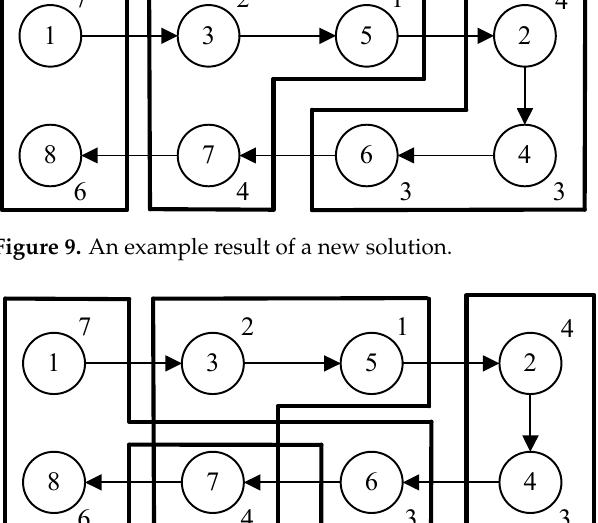
Figure 10. An example result of a new solution with interference.